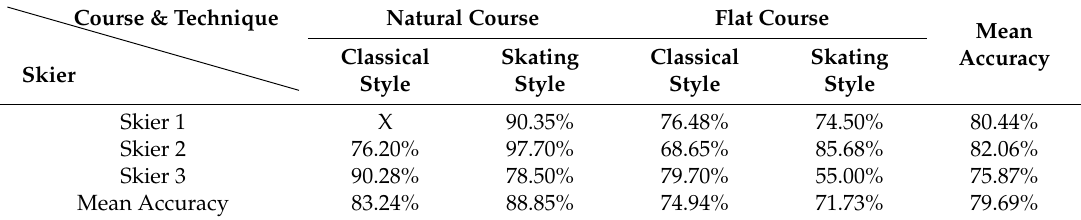
Table 15. Classification accuracies for the first three skiers using the proposed deep learning model when a leave-one-out type of testing is performed using the sports biomechanics configuration of sensors.